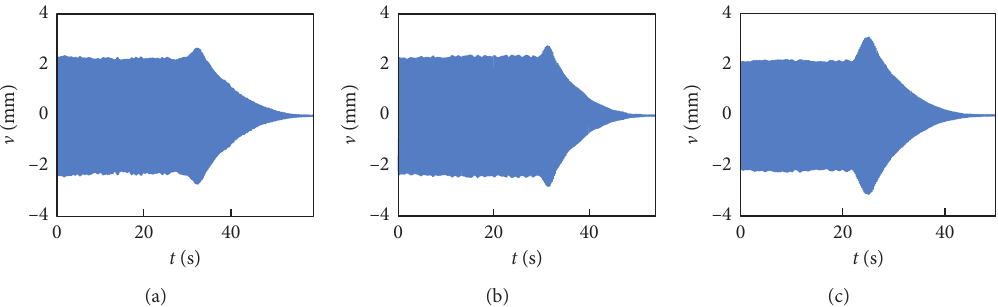
Figure 14: Time history of the first in-plane modal galloping with wind speed reduction at U U 2 � 0.533m/s. (c) U 2 �